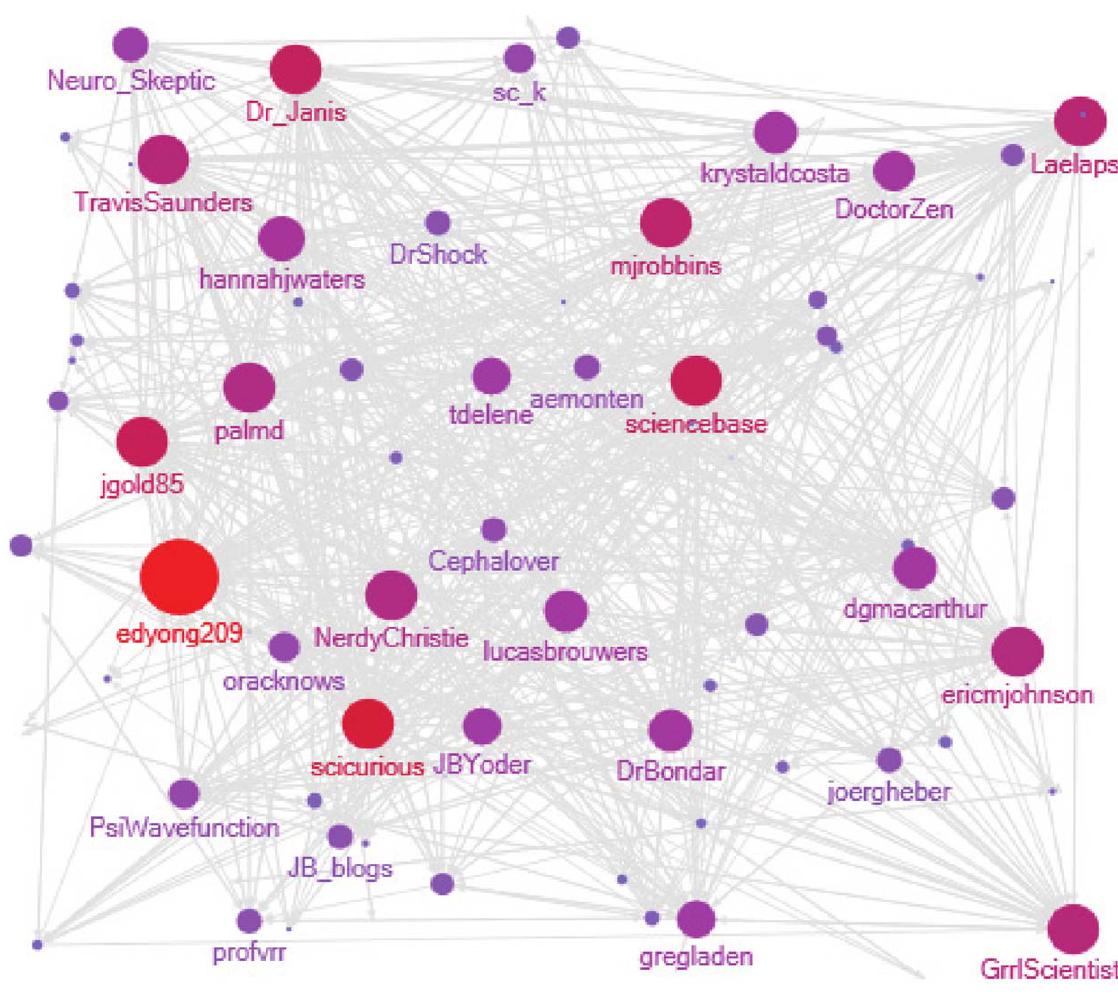
Figure 3. Twitter interconnections – followers.